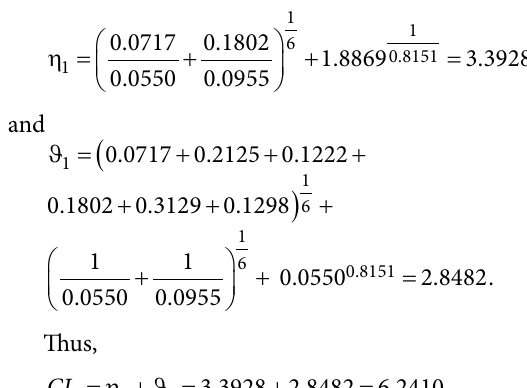
Table 5. Ratings of cross-docking candidates versus selected criteria Evaluation Cross-docking factors centers